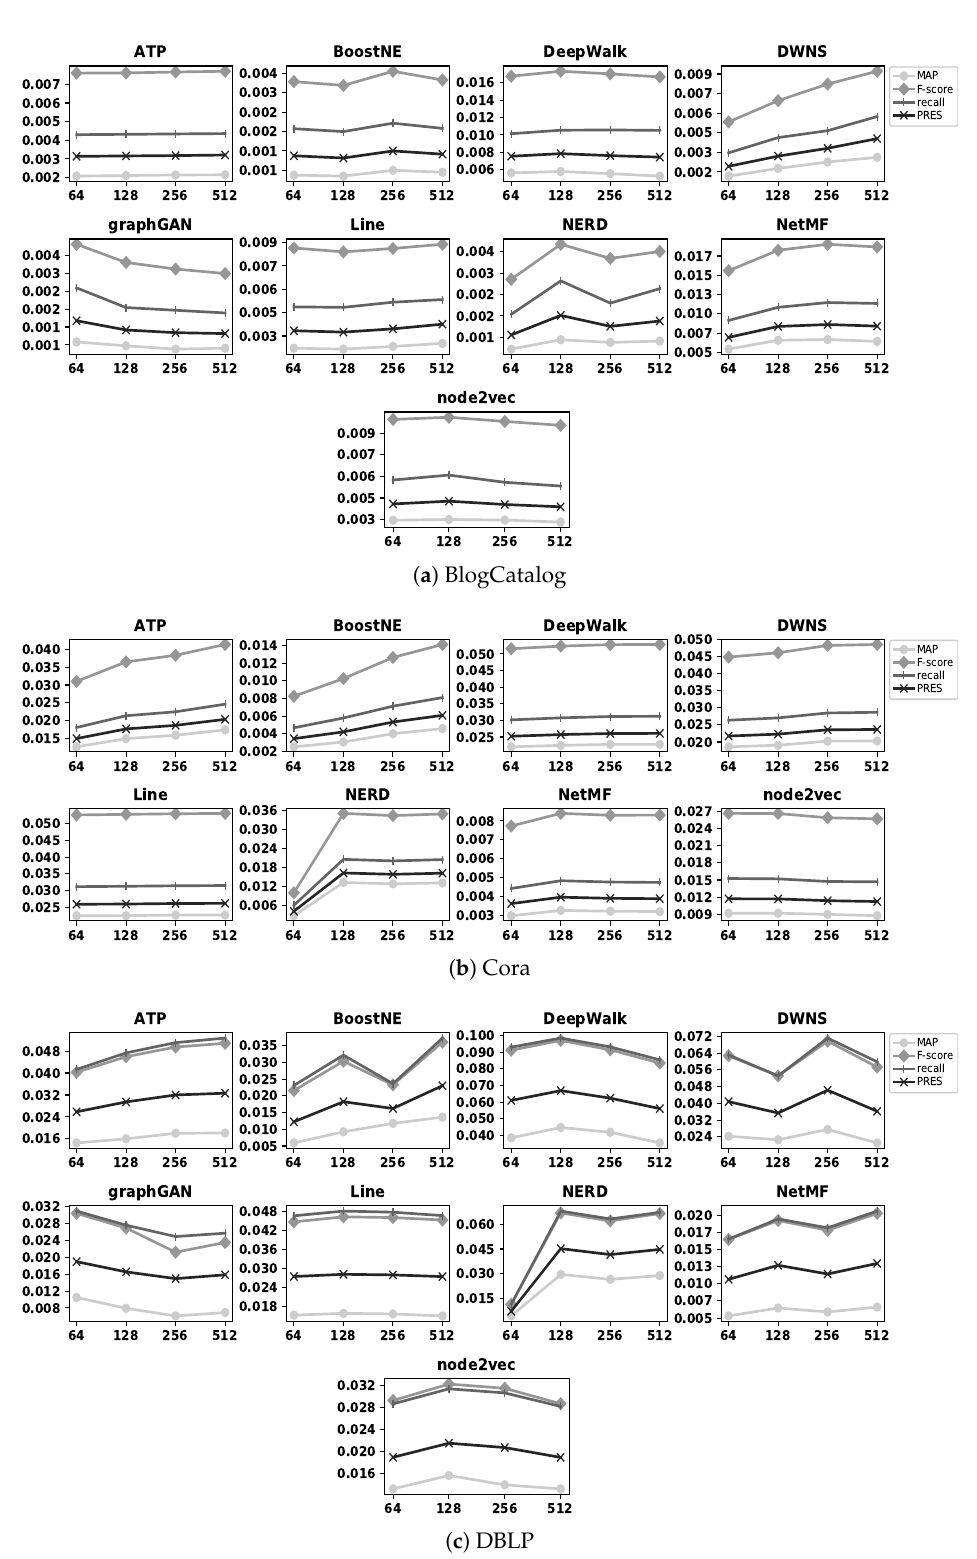
Figure 4. Accuracy of embedding methods with BlogCatalog, Cora, and DBLP datasets for different values of d